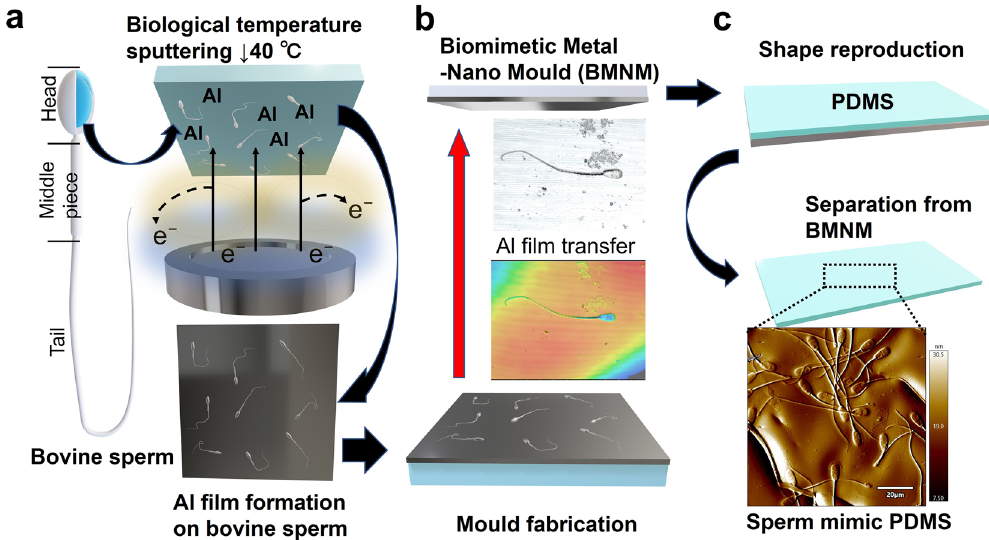
Figure 1. Schematic illustration of fabrication of biomimetic metal nano-mould (BMNM) and biomaterial shape reproduction. ( a ) Al thin film formed on adsorbed bovine sperm substrate at biological temperature. ( b ) Deposited Al thin film with preserved sperm shape. ( c ) Moulded dimethylpolysiloxane (polydimethylsiloxane, PDMS) reproduced shape of